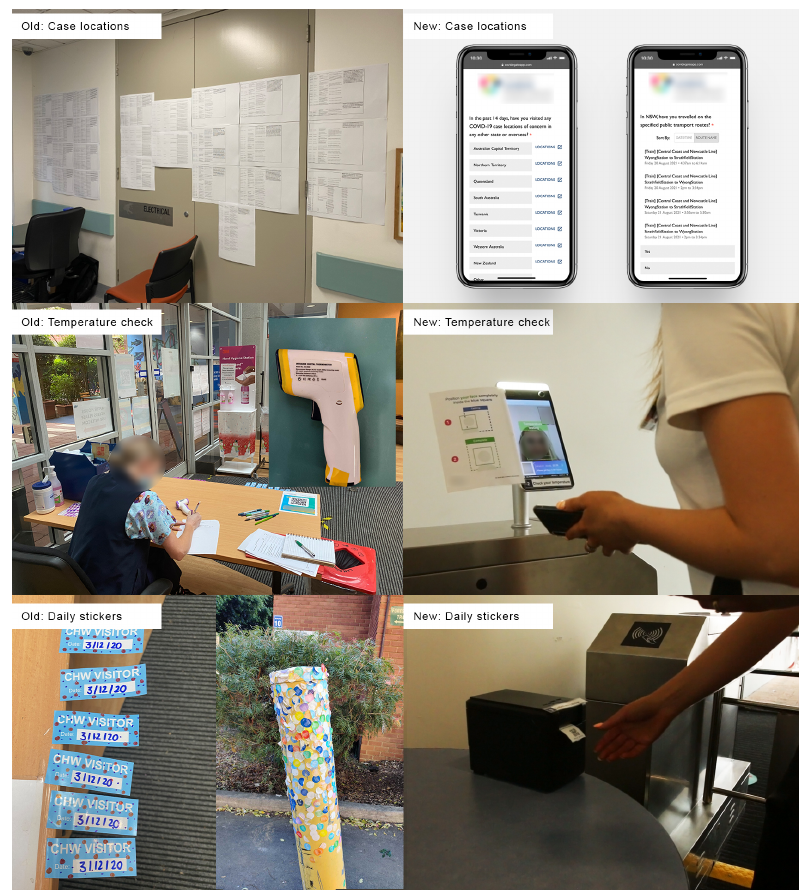
Figure 2. Contrasting the manual system with the eGate